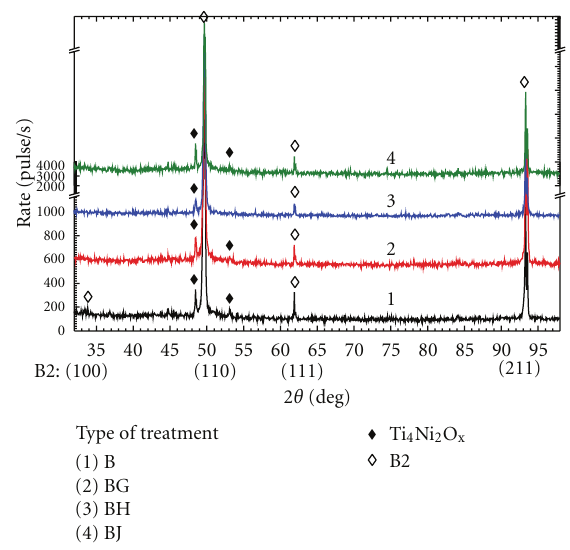
Figure 1: Di ff raction patterns of the NiTi specimens from the side of the surface treated by di ff erent methods: (1) electropolished mirror NiTi-B surface; (2), (3), (4) NiTi-B surface implanted with Zr-(BG), Ti (BH), and Si (BJ) ion beams,